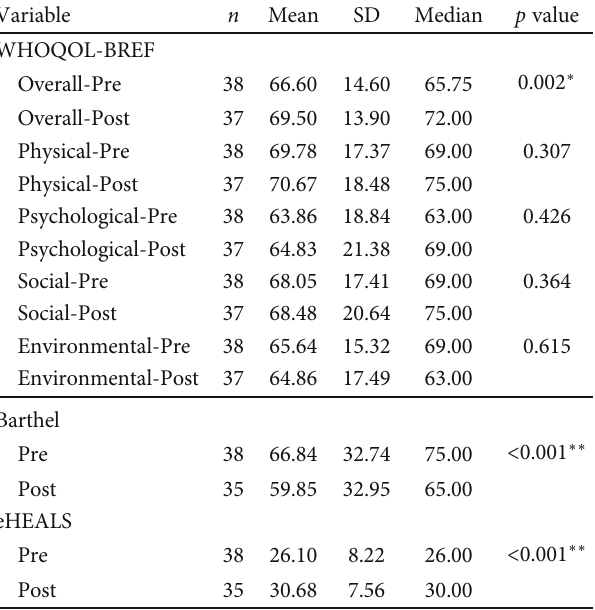
Table 3: Statistical di ff erences between caregivers ’ WHOQOL- Barthel-eHEALS pre- and